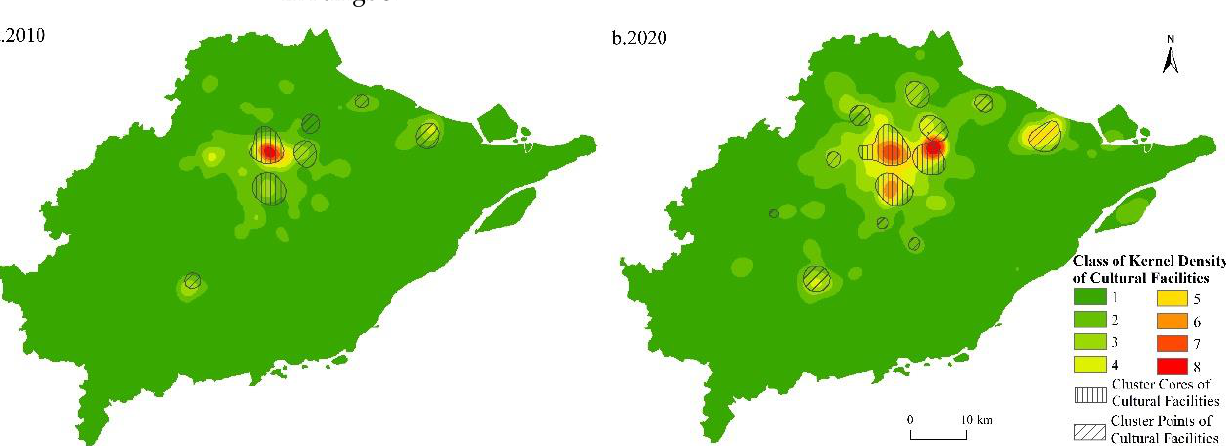
Figure 6. The spatial superposition of the agglomeration area of cultural facilities and the kernel density of cultural enterprises in the central district of Ningbo in ( a ) 2010 and ( b ) 2020. Note: This map is based on the standard map of the Map Technical Review Centre of the Ministry of Natural Resources of China (Number: Zhejiang S (2022)34), with no modifications to the base map. Map-making by the author.